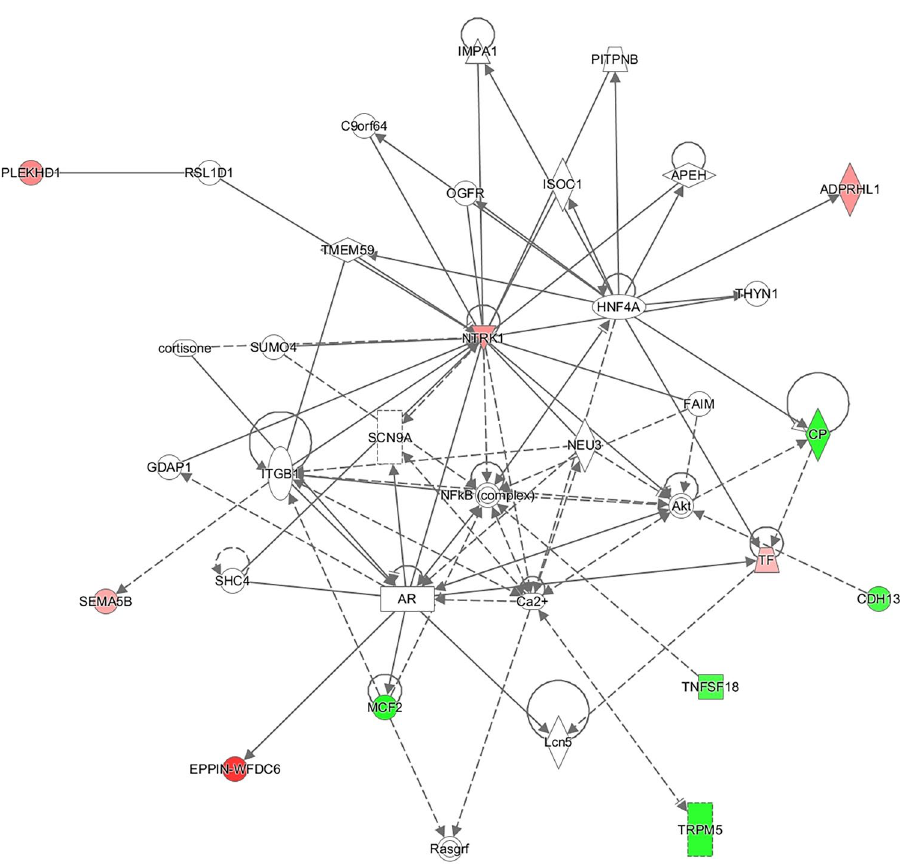
Figure 2. Network involving genes expressed in testes tissue of bull calves two divergent planes of nutrition for the first 12 weeks of life. The network is displayed graphically as nodes (genes). The node colour intensity indicates the expression of genes, with green representing down-regulation in calves fed the HI plane of nutrition compared to those fed a MOD plane of nutrition. Pink/Red represents up-regulation in HI compared with MOD calves. This image was generated through the use of IPA (QIAGEN Inc., https:// www. qiage nbio- infor matics. com/ produ cts/ ingen uity- pathw ay- analy sis) 15 ’.